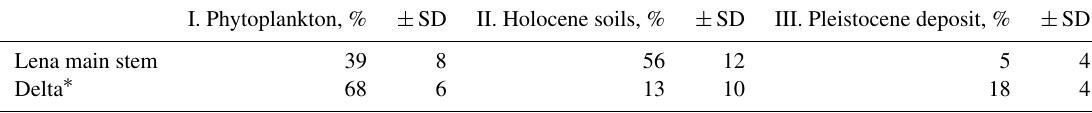
Table 2. Relative OM source contribution to water sample POC in 2019 (mean ± SD). I. Phytoplankton, % ± SD II. Holocene soils, % ± SD III. Pleistocene deposit, % ± SD Lena main